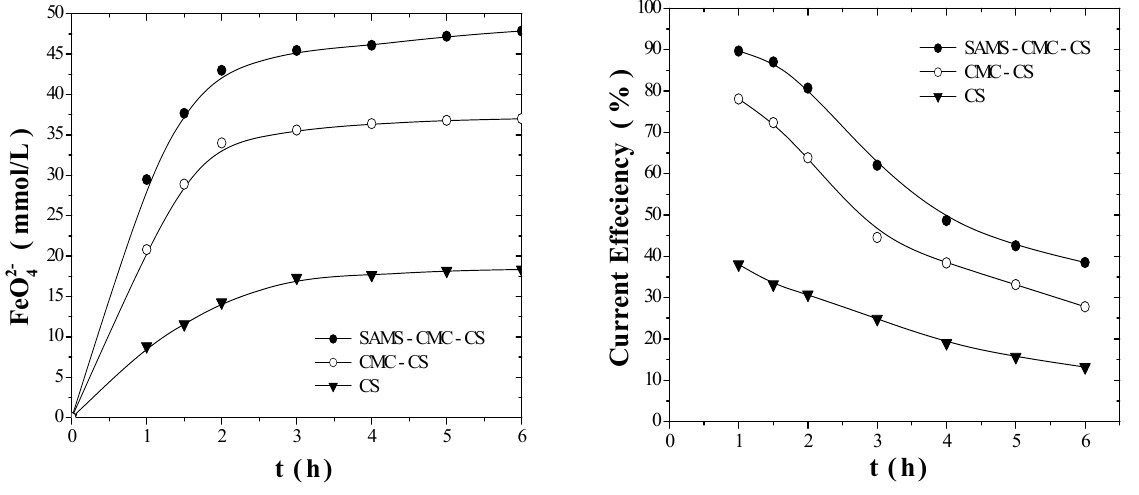
Fig. 9 Electro-generated FeO 42 − at U= 3 . 0 V on duration of electrolysis as a function of